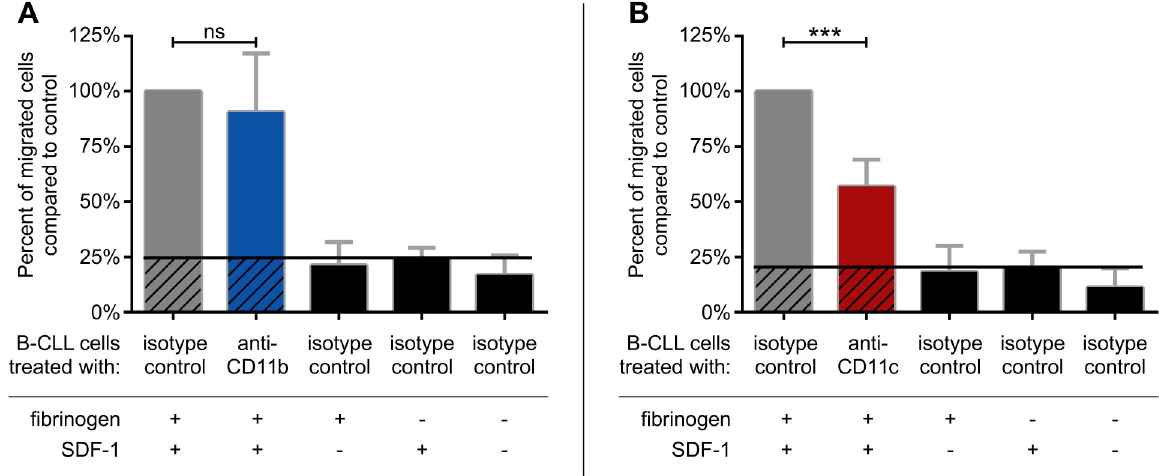
Fig 4. Migration of CLL B cells through fibrinogen coated and PLL-PEG blocked membrane towards SDF-1 can be blocked by CD11c specific antibody. (A) CD11b- or (B) CD11c- specific antibody was present throughout the assay, and the number of transmigrated cells were counted by flow cytometry. The assay was carried out on CLL B cells on the 3 rd day of culture. Results of four patients for CD11b (Patients 3, 4, 5, 7) and eight patients for CD11c are shown. Mean +/- SD, normalized to control is presented as 100%. One-way ANOVA with Tukey’s post-test was used to determine significant differences compared to control, � = p < 0.05; �� = p < 0.01, ��� = p < 0.001.